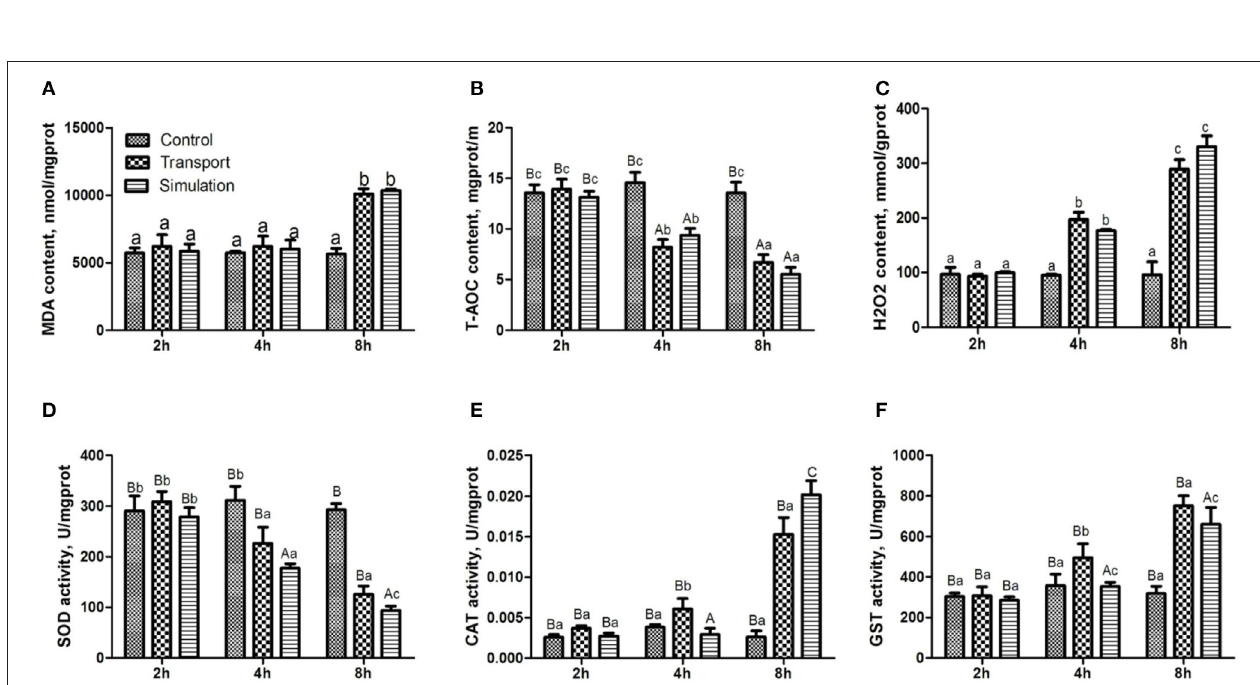
FIGURE 3 | Effects of transport stress on antioxidant function and enzyme activity in the heart of newborn chicks. (A) Malondialdehyde (MDA) content, (B) total antioxidant capacity (T-AOC) content, (C) Hydrogen peroxide (H 2 O 2 ) content, and (D) total superoxide dismutase (T-SOD) activity. (E) catalase (CAT) activity, (F) glutathione S-transferase (GST) activity. Data are presented as the mean ± SD. Compared with the control: Row (Column) with different capital letter superscripts indicates an extremely significant difference ( p < 0.01); Row (Column) with different small letter superscripts indicates a significant difference ( p < 0.05); Row (Column) with different small letter superscripts indicates no significant difference ( p > 0.05). Control, the control groups; Transport, the transport groups; Simulation, the simulation transport groups; g prot, gram of protein; mg prot, milligram of